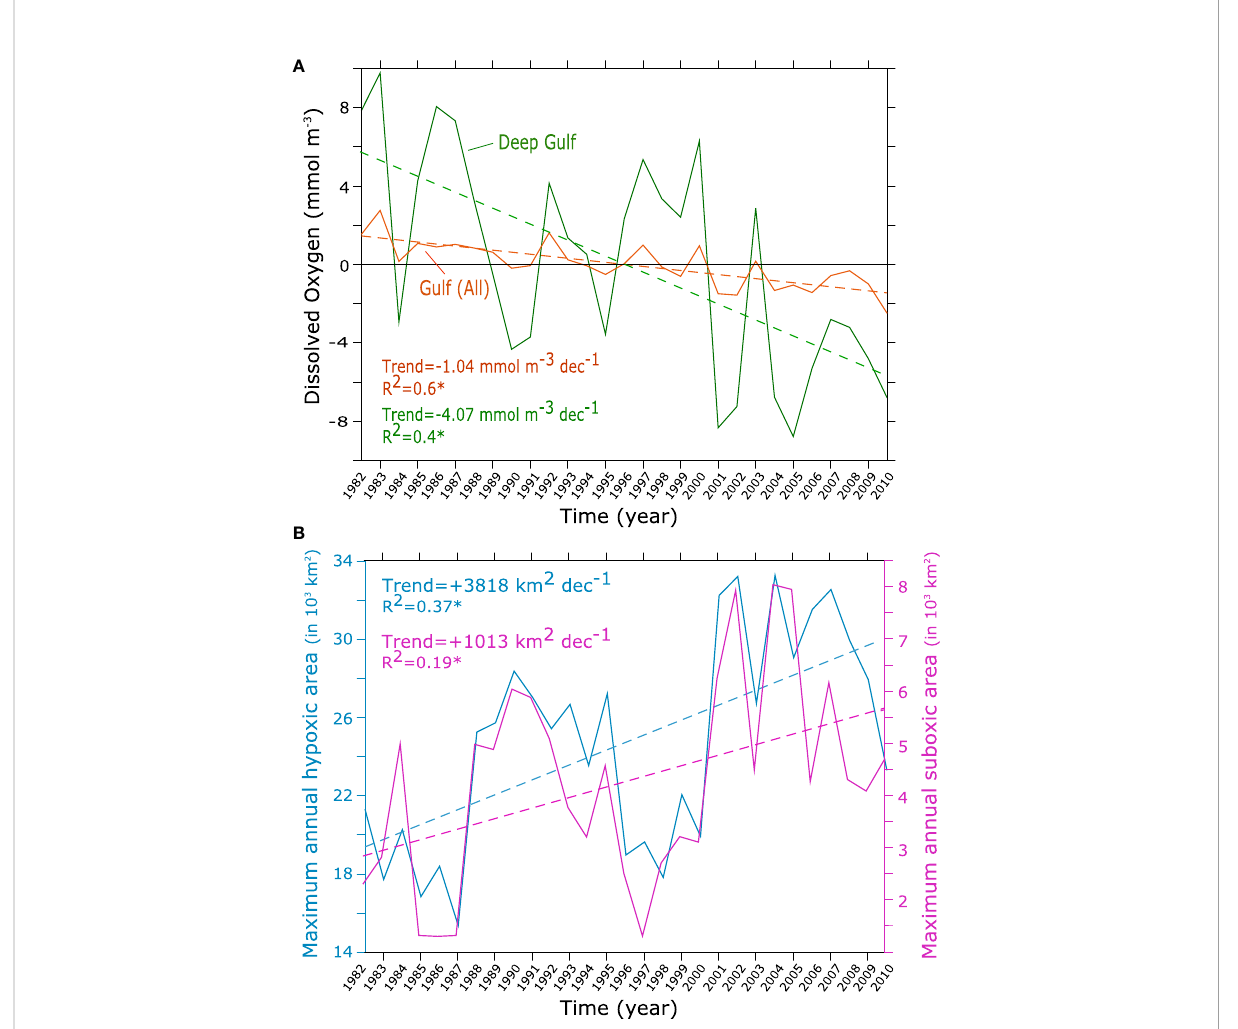
FIGURE 4 Gulf deoxygenation trends. (A) O 2 anomalies and trends over the entire Gulf (orange) and the deep Gulf (green) between 1982 and 2010. The deep Gulf corresponds to the Gulf region with a bathymetry deeper than 50 m. (B) Evolution of the annual maximum area of hypoxia (blue) and suboxia (purple) (in x 1000 km 2 ) between 1982 and 2010. Dashed lines indicate the trend